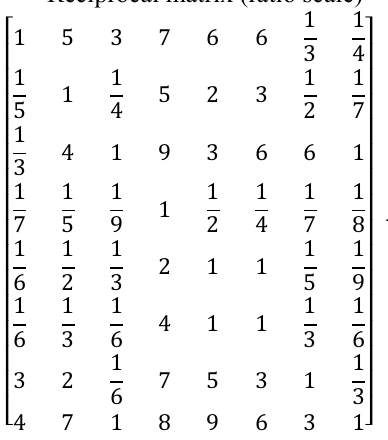
Reciprocal matrix (ratio scale) skew-symmetric matrix (additive